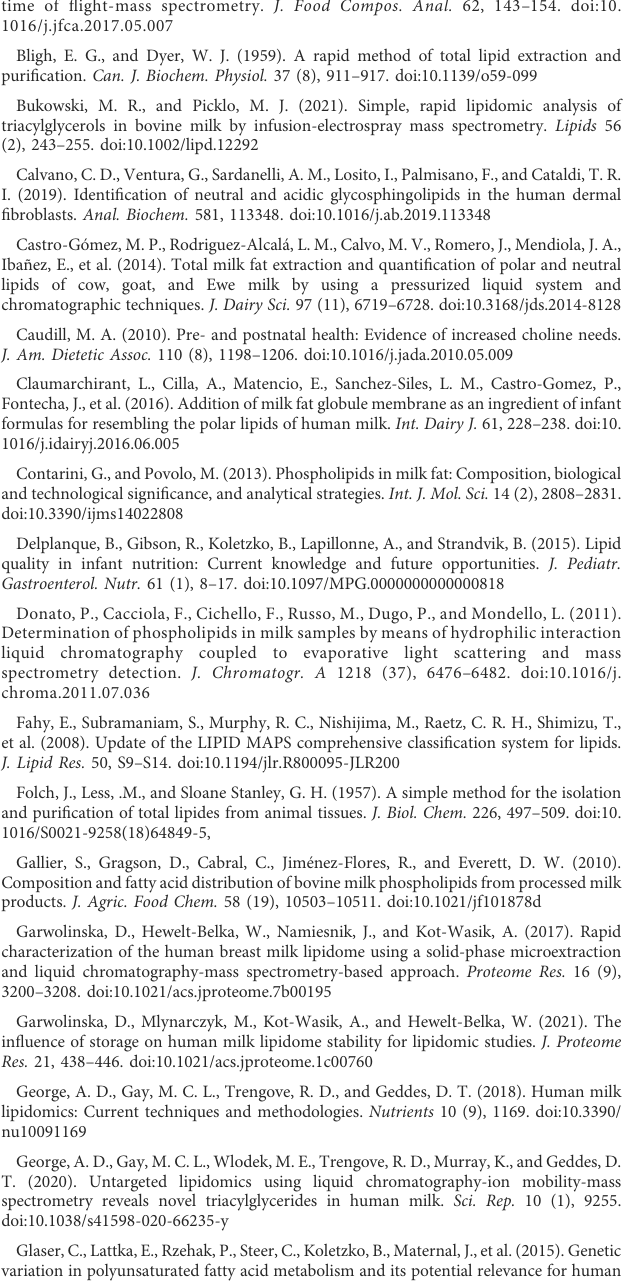
SUPPLEMENTARY FIGURE S10 (A) MS/MS fragments of GM3 36:1;2 acquired in negative ion mode; (B) MS/MS fragments of GD3 34:1;2 acquired in negative ion mode. SUPPLEMENTARY FIGURE S11 (A) Extracted ionchromatogramofSM38:1;2acquired inpositive ionmode; (B) Extracted ion chromatogram of PE 36:2 acquired in negative ion mode; (C) Extracted ion chromatogram of TAG 52:3 acquired in positive ion mode; (D) Extracted ion chromatogram of FFA 18:1 acquired in negative ion mode; (E) Extracted ion chromatogram of GM3 36:1;2 acquired in negative ion mode.